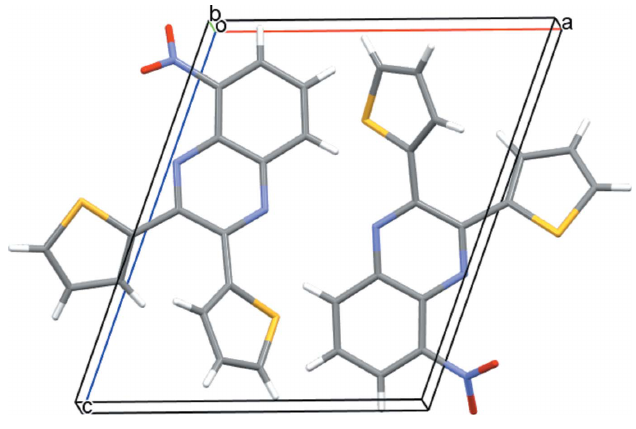
Figure 2 A view of the unit cell of 5-nitro-2,3-bis(thiophen-2-yl)quinoxaline along